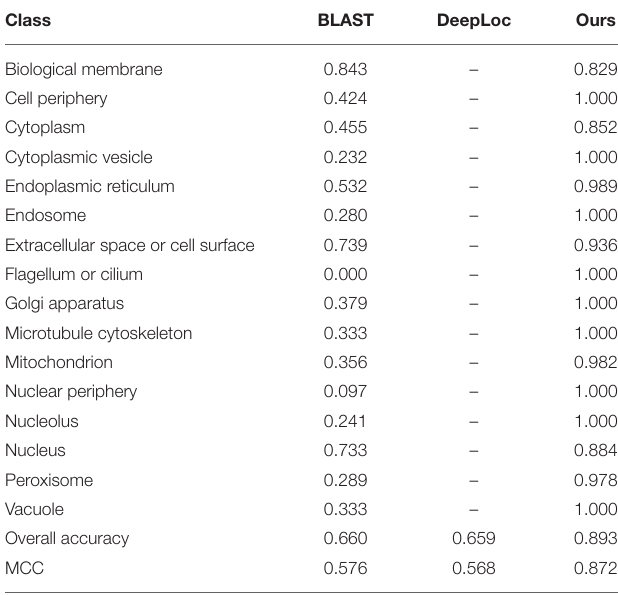
TABLE 3 | Performance of BLAST, DeepLoc, and our proposed